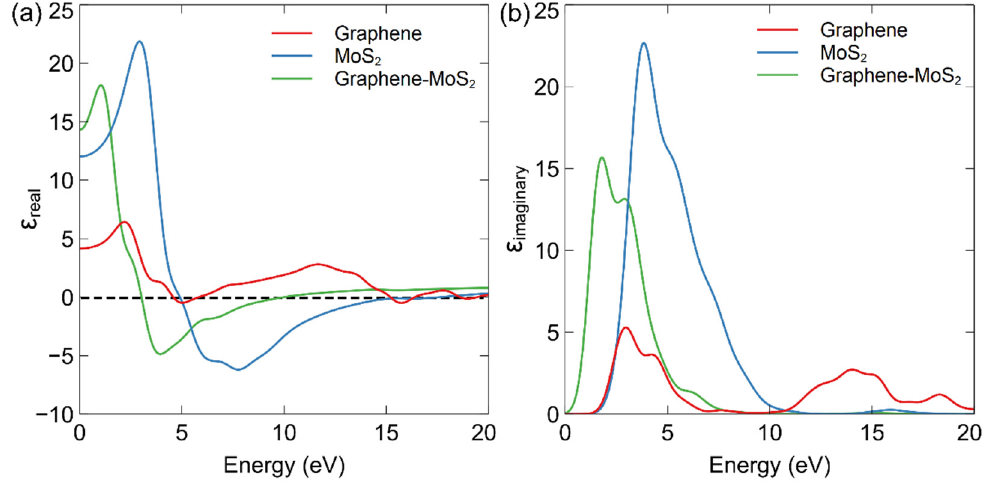
Figure 4. Theoretical real and imaginary part of dielectric function of simulated graphene, MoS 2 , and graphene-MoS 2 ( a ) real and ( b ) imaginary. graphene-MoS 2 ( a ) real and ( b )